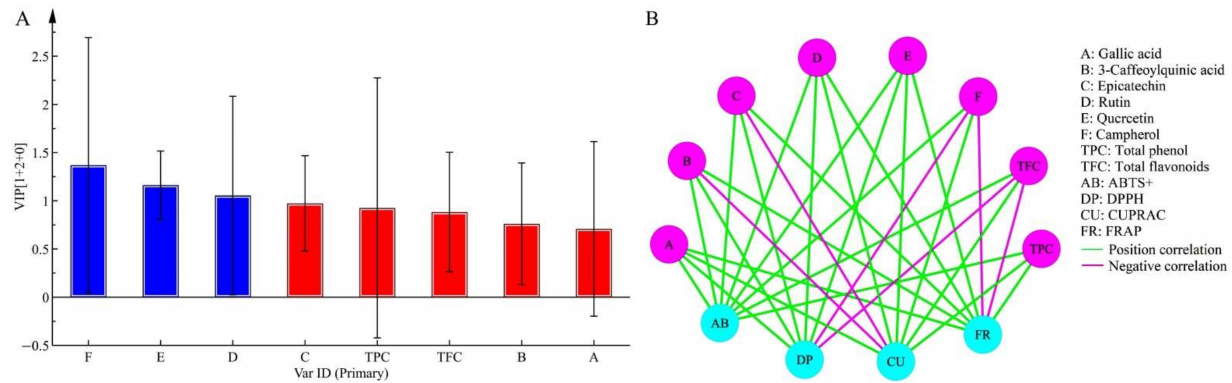
Figure 2. VIP value diagram ( A ) and correlation diagram ( B ) of antioxidant capacity and phenolic compounds in seven fermentation stages of apricot juice. Each node represents phenolic compounds or antioxidant capacities. The green solid line and purple solid line represent positive and negative correlation, respectively. In addition, line width indicates the strength of correlation.